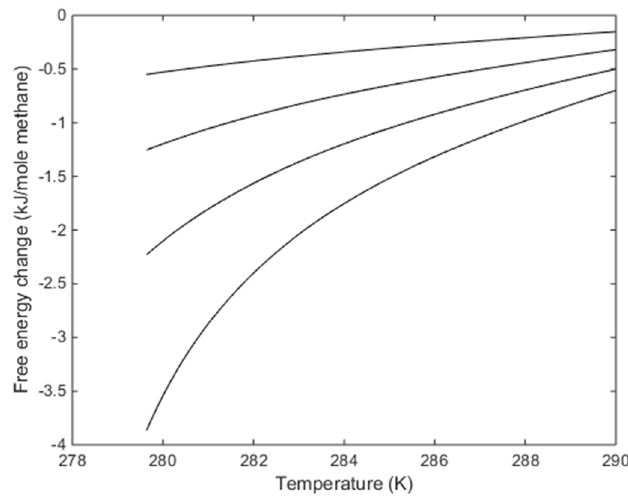
Figure 10. Isothermal free energy changes for dissociation pressure reductions from equilibrium pressures in Figure 3. Lowest curve are for 40 bars reductions from the equilibrium pressures, then 30 bars reduction, 20 bars reduction and upper curve for 10 bars reduction from equilibrium pressures.